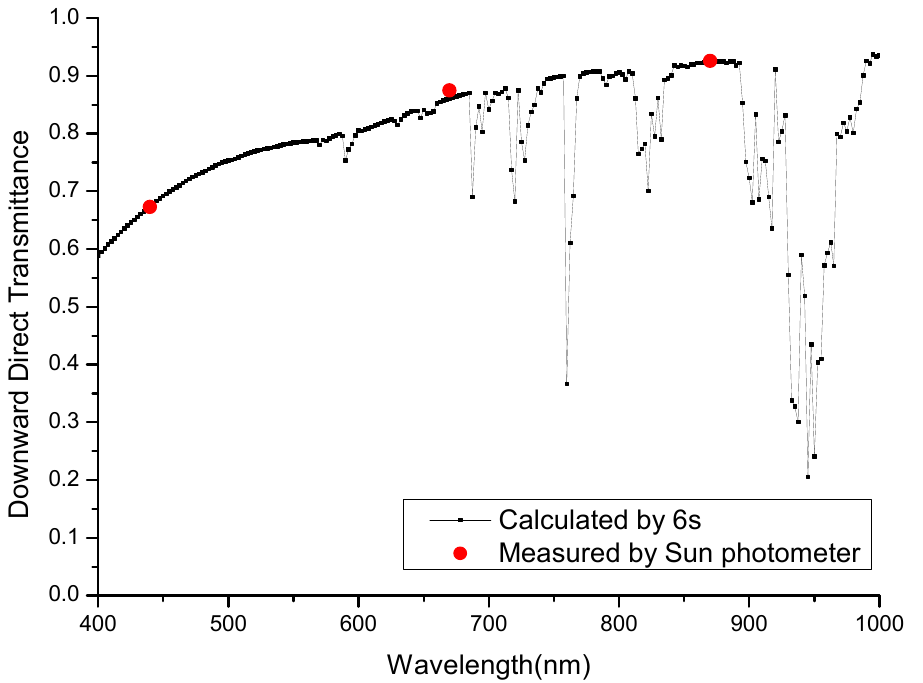
Figure 8. Comparison of transmittance between sun photometer measurement and 6S calculation on 18 August 2018.